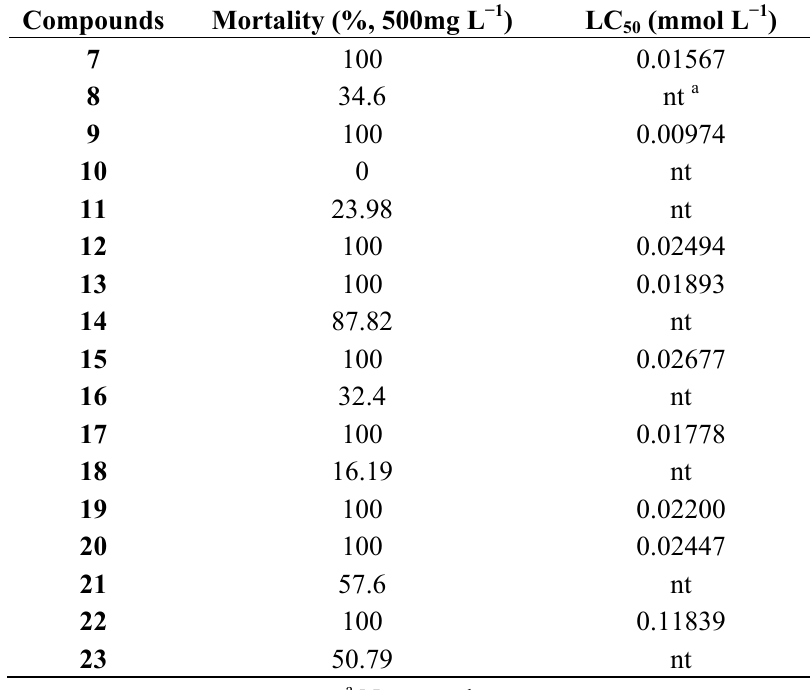
Table 1. Insecticidal activities of compounds 7 – 23 against cowpea aphids ( Aphis craccivora